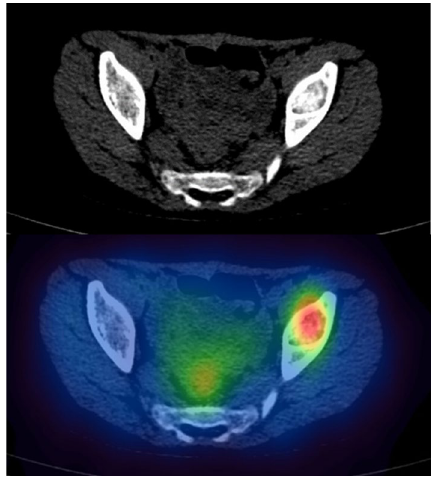
Fig. 11 Axial CT and SPECT/CT of a bone metastases in [ 131 I]mIBG